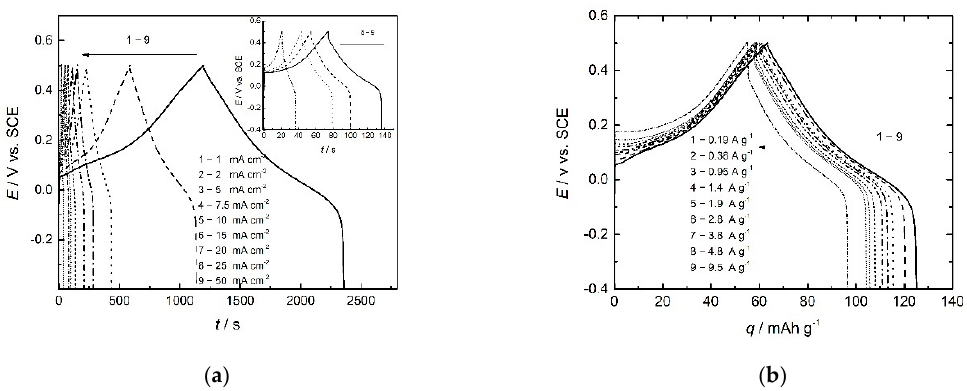
Figure 7. Charge/discharge curves of PANI electrode obtained with different current densities/spe- cific currents as marked ( a ) over time, ( b ) over recalculated specific capacity.